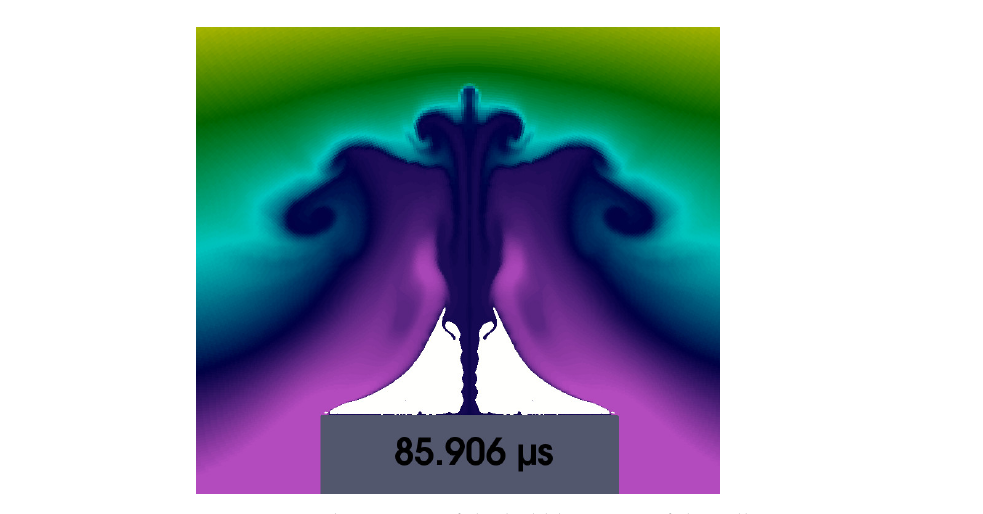
Figure 13. Enlargement of the bubble on top of the pillar at time 85.906 µs with the warped color layer tracer field of Figure 12. The white area is the bubble foot stand. It still collapses further. A stack of vortices develops from the upwards